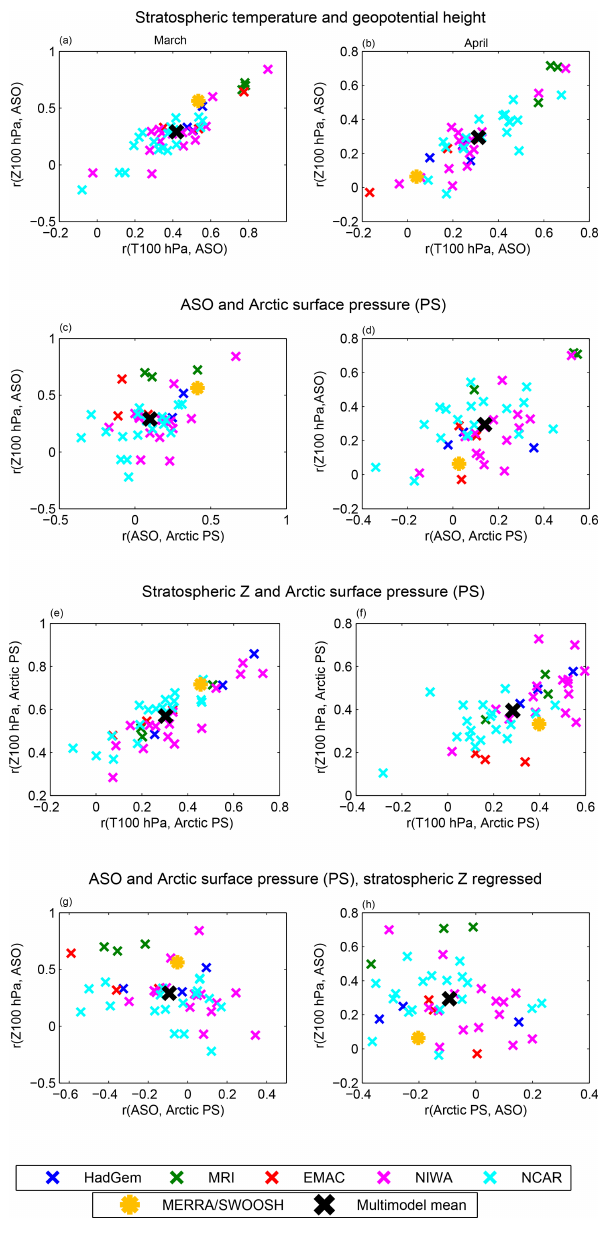
Figure 4. The connection between correlations of ASO anoma- lies and anomalies in various metrics of the stratosphere and tro- posphere. In each subplot, the x and y axis represent correlation of two measures. Each x represents a different 41-year chunk of model output, and reanalysis/observational data is represented by asterisks. The first row compares the correlation of ASO with polar cap stratospheric temperature (T) with the correlation of ASO with polar cap geopotential height (Z) in (a) March and in (b) April. The second row compares the correlations of ASO and polar cap height (Z) with ASO and polar cap surface pressure (PS). The third row compares the correlations of polar cap Z and PS with polar cap T with PS. The fourth and final row is similar to the second row except that polar cap Z is regressed